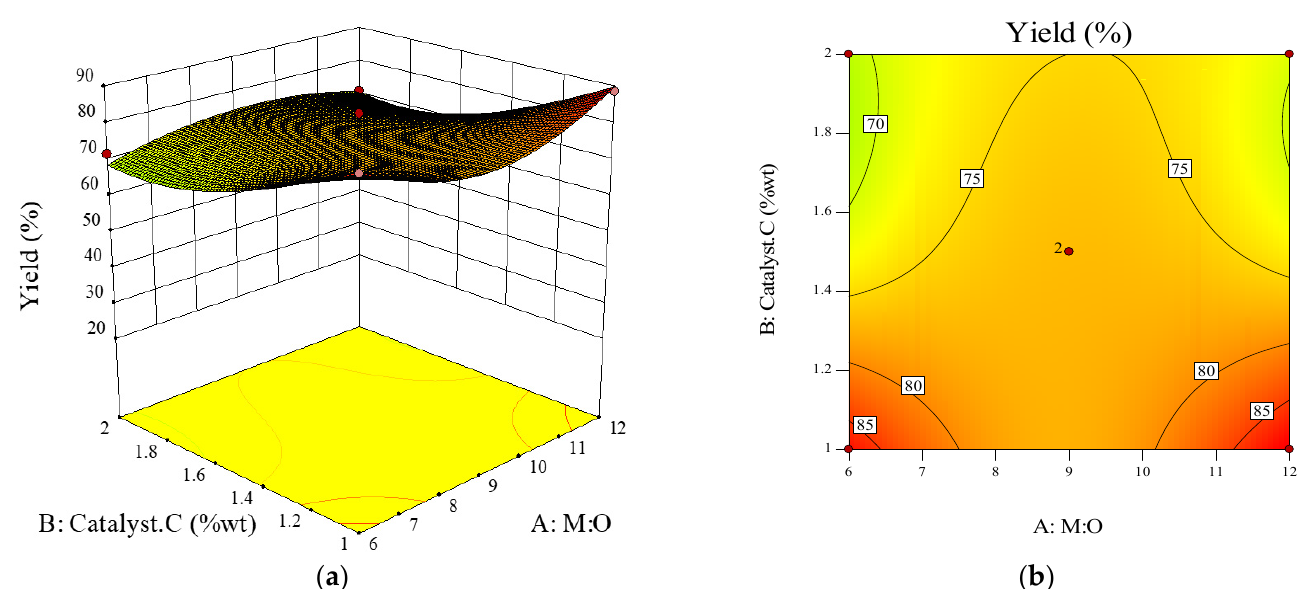
Figure 6. The effect of KOH catalyst amount, methanol-to-oil molar ratio, and their reciprocal interaction on chicken feet biodiesel synthesis using the 45 kHz ultrasonic frequency, ( a ) response surface 3D plot, ( b ) contour plot.